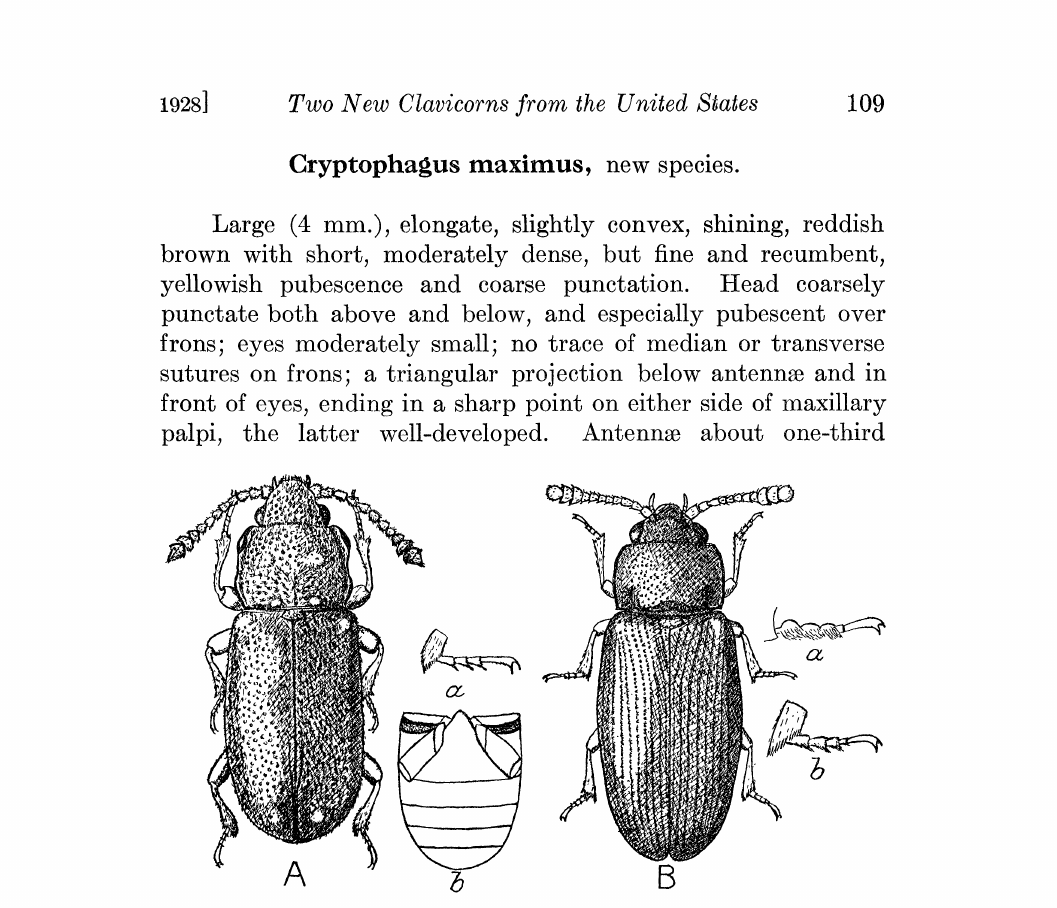
Fig. 1.--A. Cryptophagus maximus, (a) male hind tarsus, (b) ventral surface showing trochanters and abdominal segments. B. Pharaxonotha zamiae, (a) male (?, anterior tarsus, (b) hind tarsus. length of beetle with loose g-iointed club, the last two segments of club being approximately same width, slightly wider than first ioint of club, and markedly wider than preceding segments; first antennal segment large, globose, second one-third smaller, third longer than any other except